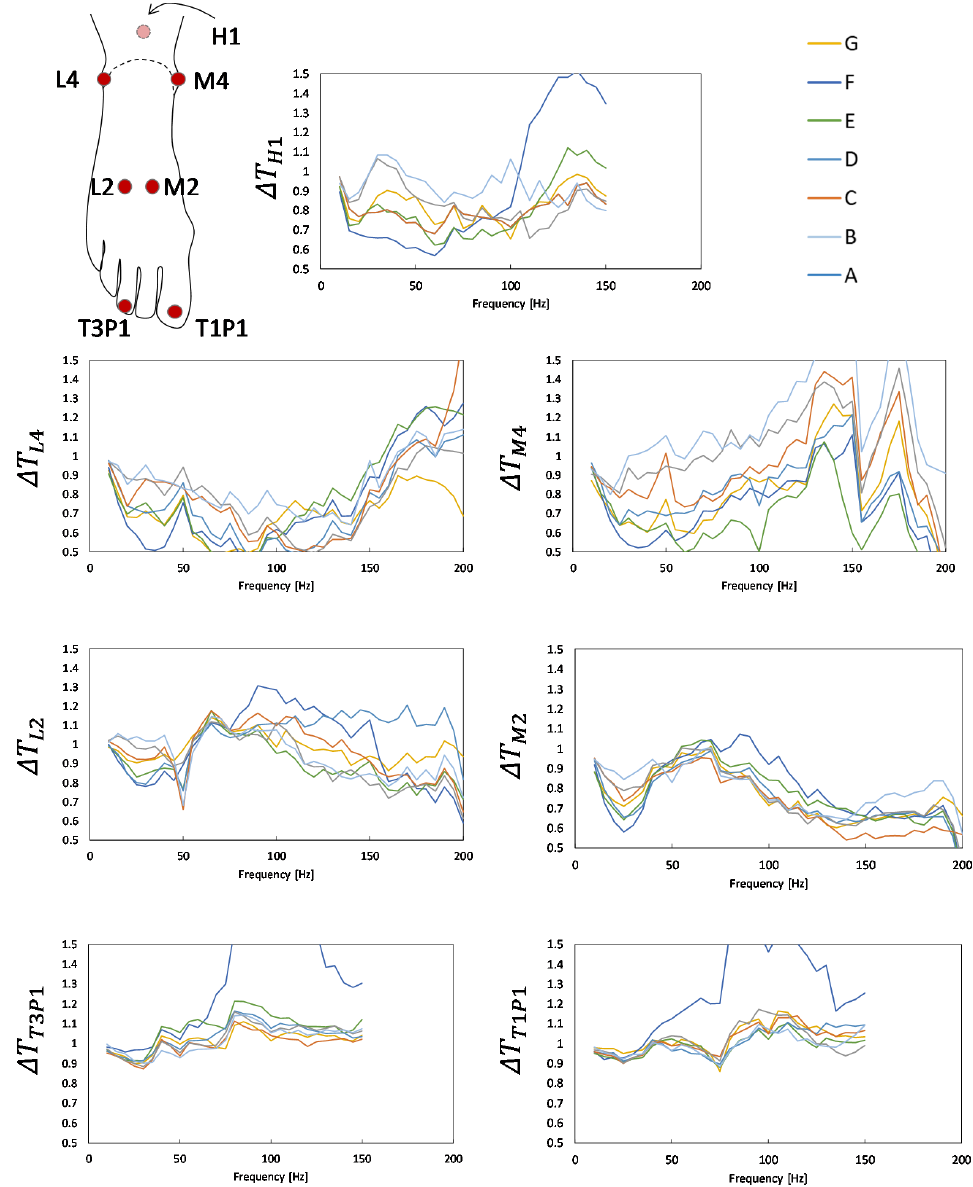
Figure 6. Comparison between the transmissibility measured with different materials with respect to that measured in barefoot.